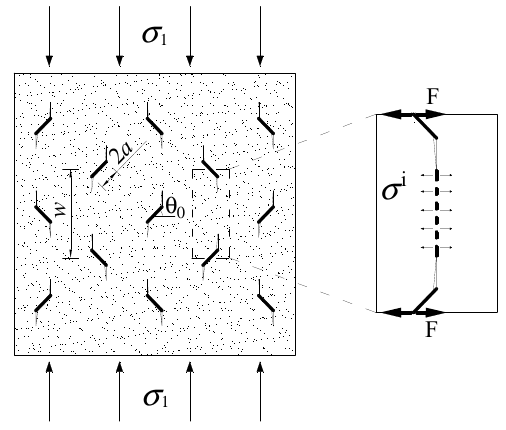
Figure 13. Diagram of the interaction of multiple cracks.